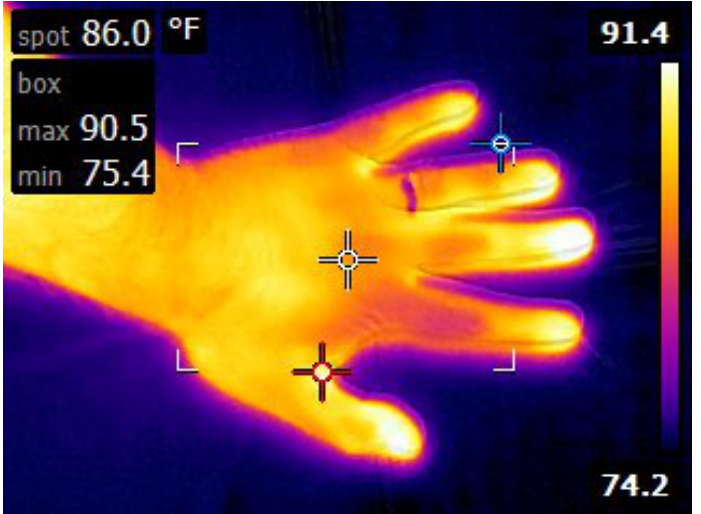
Figure 1. Example of how emissivity and reflected background can affect an infrared image. The ring appears cooler than the hand although they are both at the same temperature